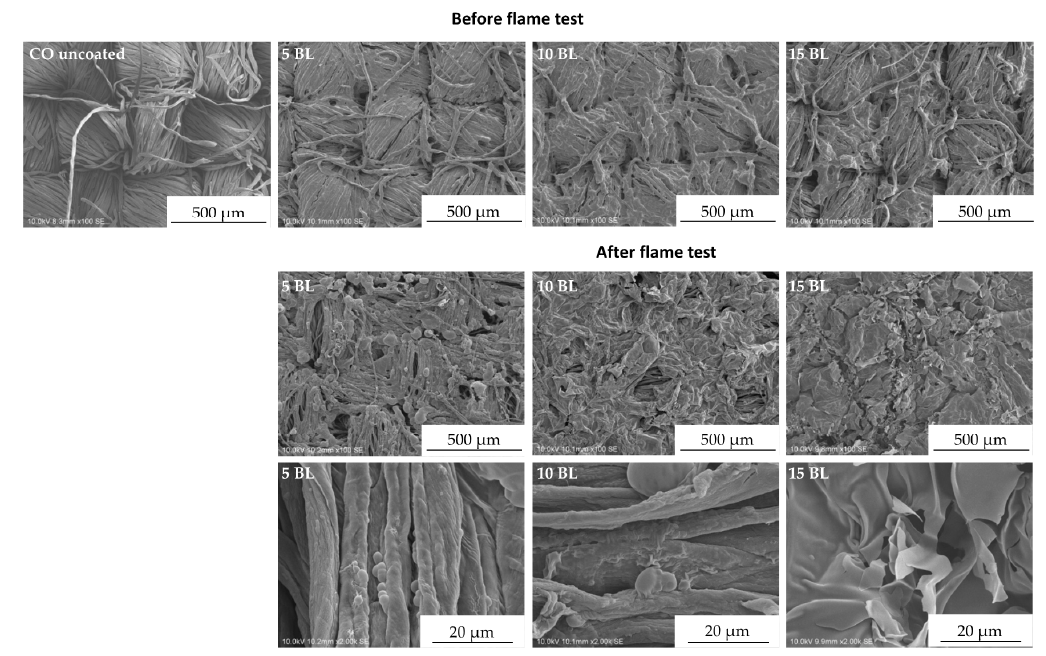
Figure 5. Scanning electron microscopy top view images of untreated, treated and burned cotton fabrics. Top row: fabrics before flame test; middle and bottom row: charred samples after flame test in different magnifications.